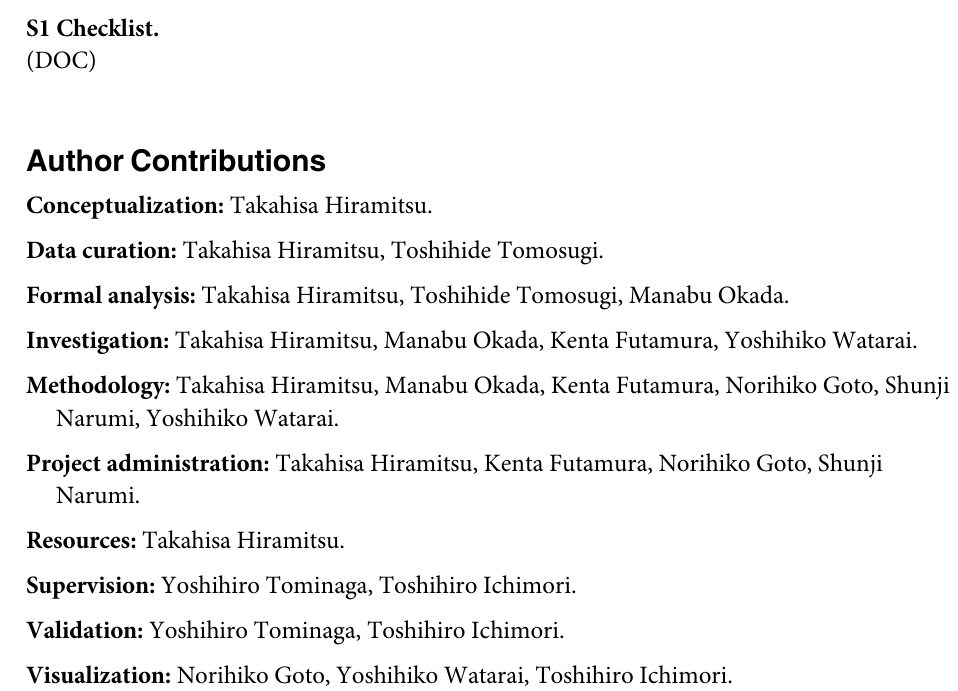
S2 Table. Contingency table of the intact PTH